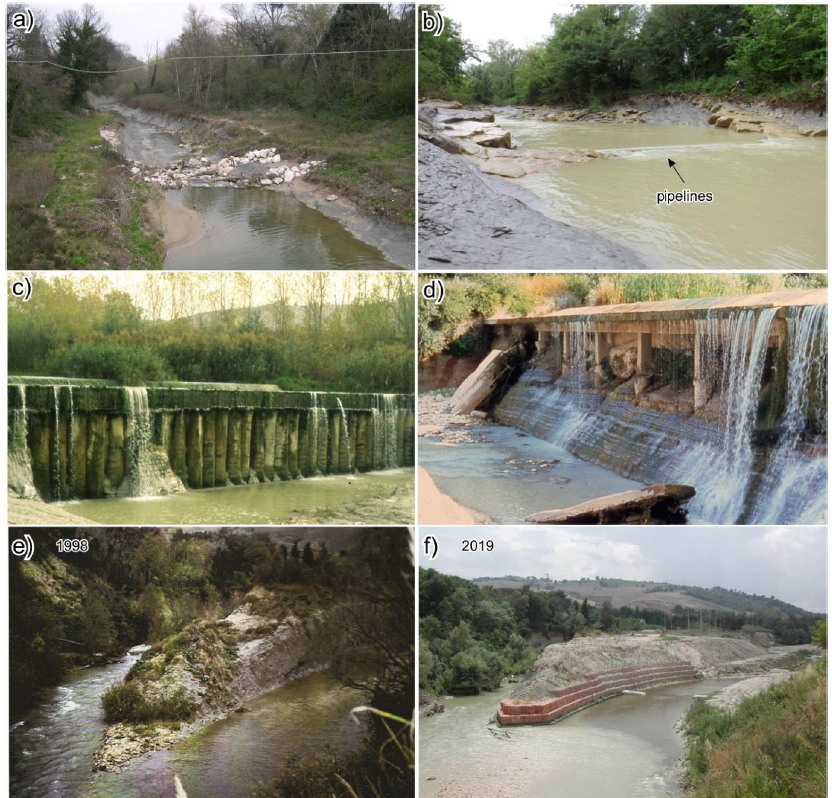
Figure 2. Deepening phenomena observed along some river reaches of the study area: ( a , b ) recent thalweg erosion along the Chienti River (in the second image, three pipelines have been exposed by erosion); ( c , d ) deepening phenomena occurred in correspondence of two check dams (Tenna and Potenza River respectively) during the last 20 years; ( e , f ) river incision occurred in just over 20 years in correspondence of the wastewater treatment plant of Tolentino (C2 — Chienti River).